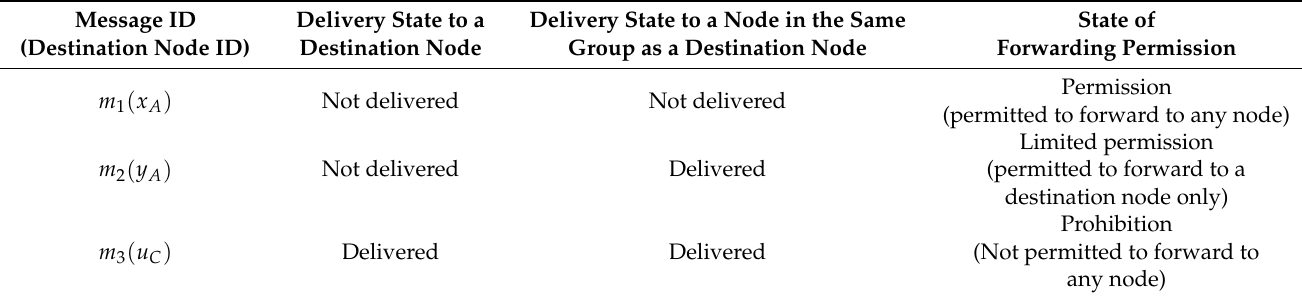
Table 2. Overload control table of the proposed proactive overload control